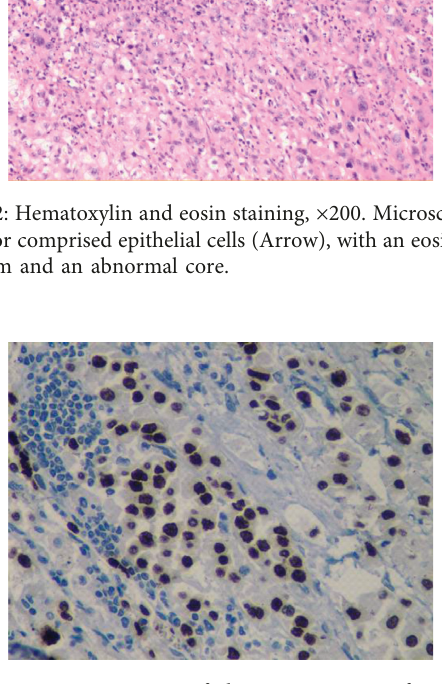
Figure 3: Immunostaining of the tumor was performed with TTF-1, CK7, and CK20, all of which were positive ( ×